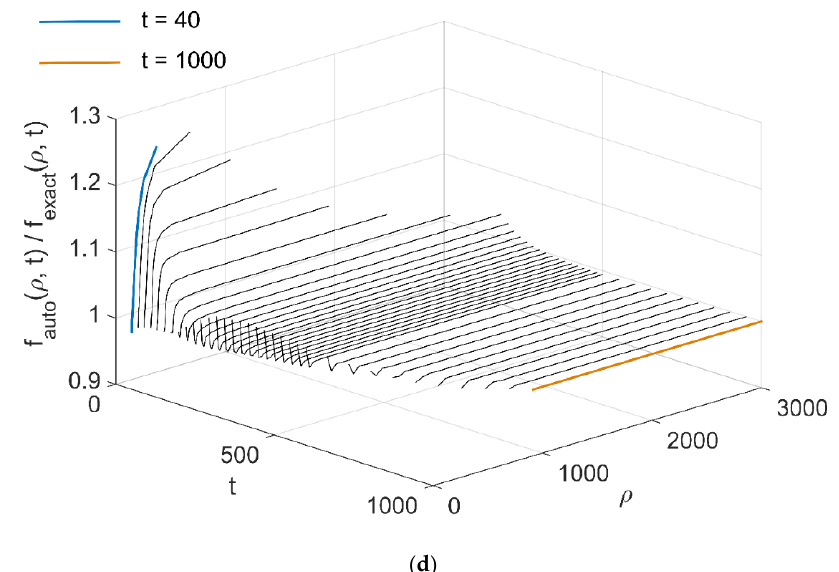
Figure 6. The result of accuracy analysis of automodel solution for the propagation front ρ = ρ fr taken in the form of Equation (24), for different values of t in the range from t min = 40 to t max = 10 3 with the time step equal to 20, if 40 ≤ t ≤ 500. and 50, if 500 < t ≤ 1000: ( a ) functions Q G2 ( s , t ) (29); ( b ) normalized functions Q G2 ( s , t )/{ Q G2 }*( s,t ), where { Q G2 }*( s,t ) is equal to Q G2 ( s , t = 160 ), for small s , and Q G2 ( s , t = 10 3 ), for large s ; ( c ) relative error of the automodel solution f auto ( ρ , t )/ f exact ( ρ , t ); and ( d ) the same in the 3D view.